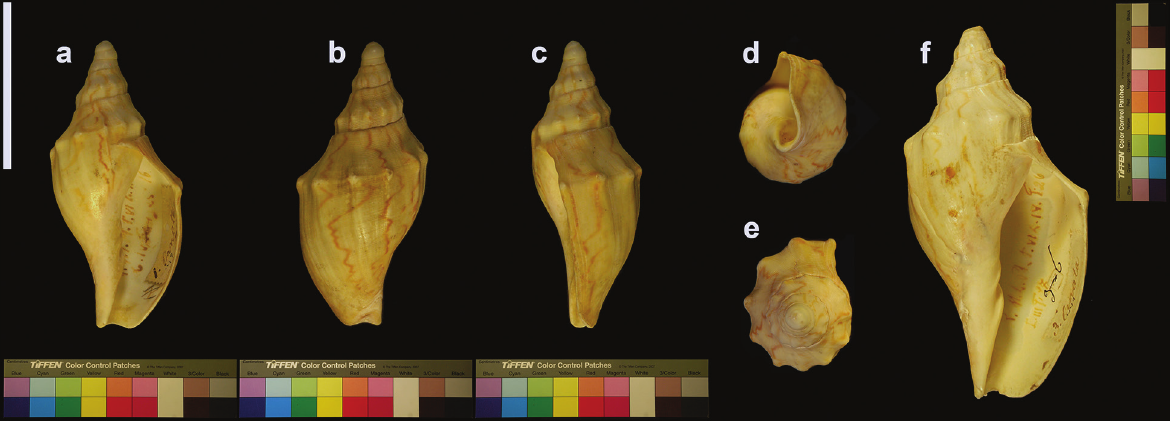
Figure 40. Voluta fusiformis ornata . a–e Specimen figured by Lahille (1895: pl. III, fig.16; pl. IV figs 24, 25) a Apertural view b Dorsal view c Lateral view d Umbilical view e Apical view f Specimen figured by Lahille (1895: pl. III, fig. 17; pl. IV, fig. 26). Scales bar: 5 cm.